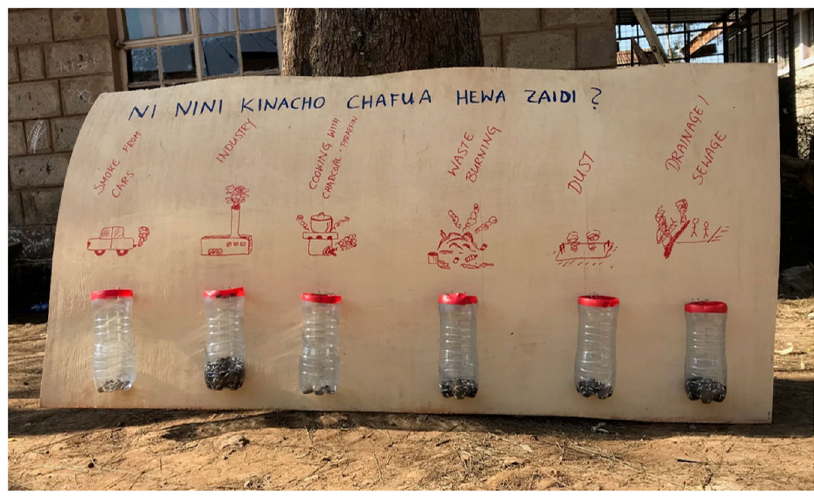
Fig. 3 Photograph showing the results from a playful activity exploring air pollution sources with Mukuru residents at the Hood2Hood festival. Residents were asked to put counters into the ‘ top 3 ’ sources of air pollution in Mukuru. The title translates as ‘ What pollutes the air most? ” . Initial options included were designed in partnership with community